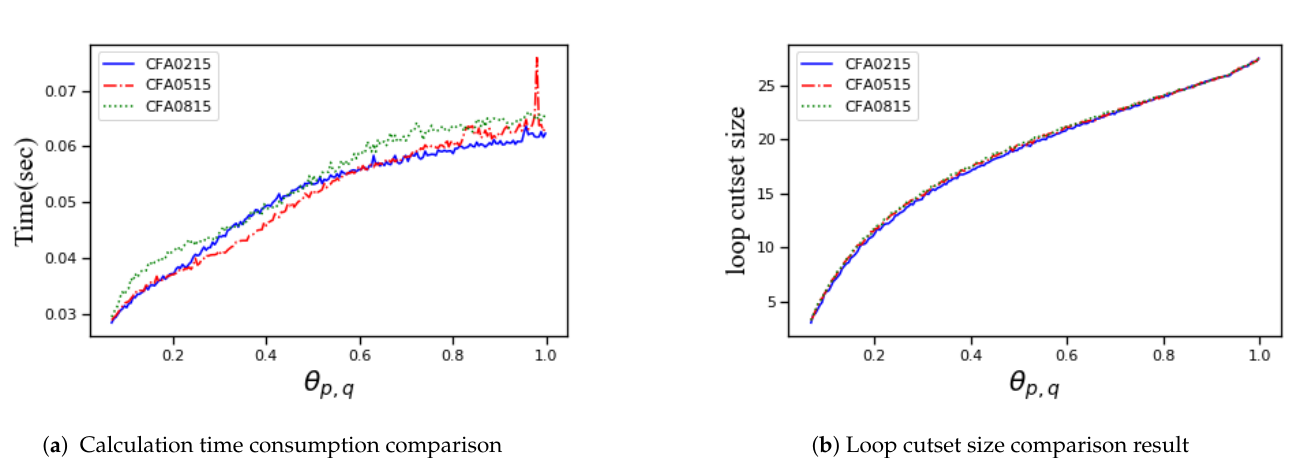
Figure 8. Keep the ω unchanged and change the value of µ , the comparison chart of the results of the CFA algorithm.